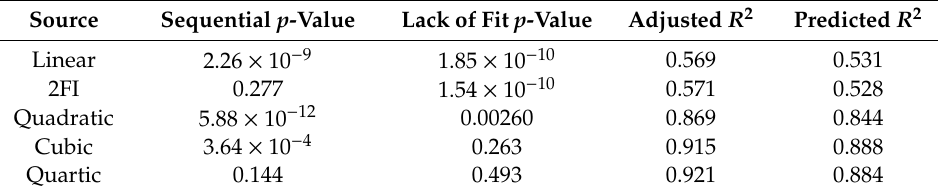
Table 9. Summary of the comparison between models for the τ u parameter for unbending. Source